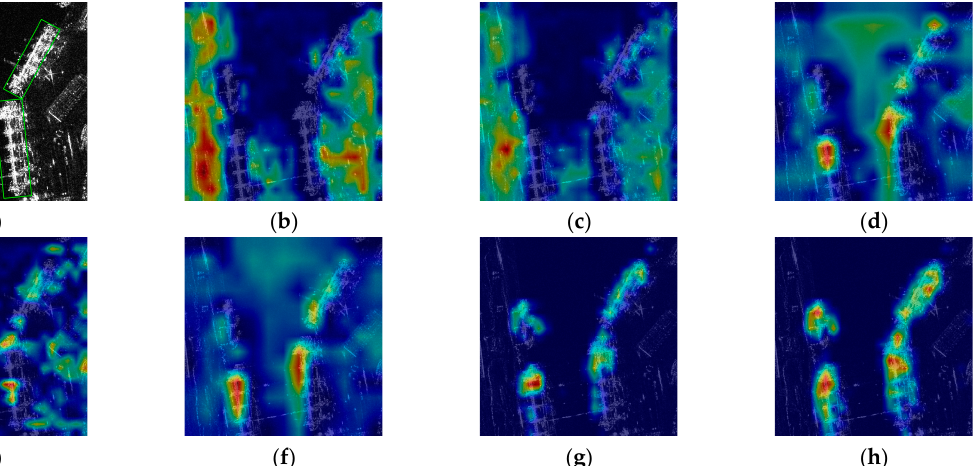
Figure 23. Feature visualization of different feature fusion networks (take P 5 as an example). ( a ) Input; ( b ) FPN (ADD); ( c ) PANet (ADD); ( d ) BiFPN (LWF); ( e ) AW-FPN (ADD); ( f ) AW-FPN (LWF);